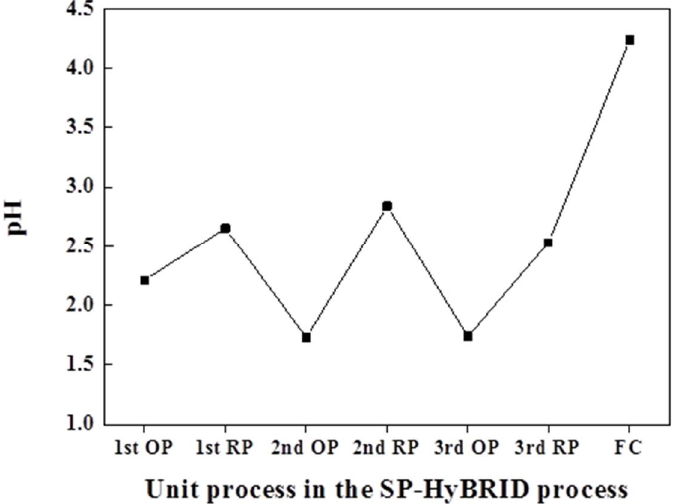
Figure 6. pH changes in each unit process solution during the mock-up test (OP: oxidative process, RP: reductive process, FC: filter cleaning).